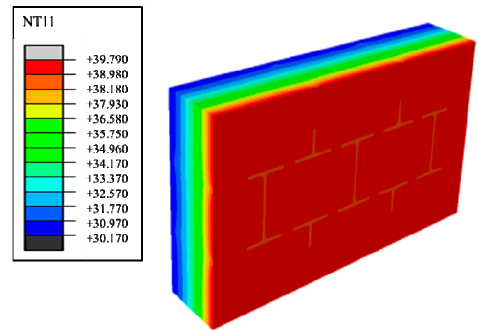
Figure 5. Steady heat transfer heat flux nephogram (containing decanoic acid).